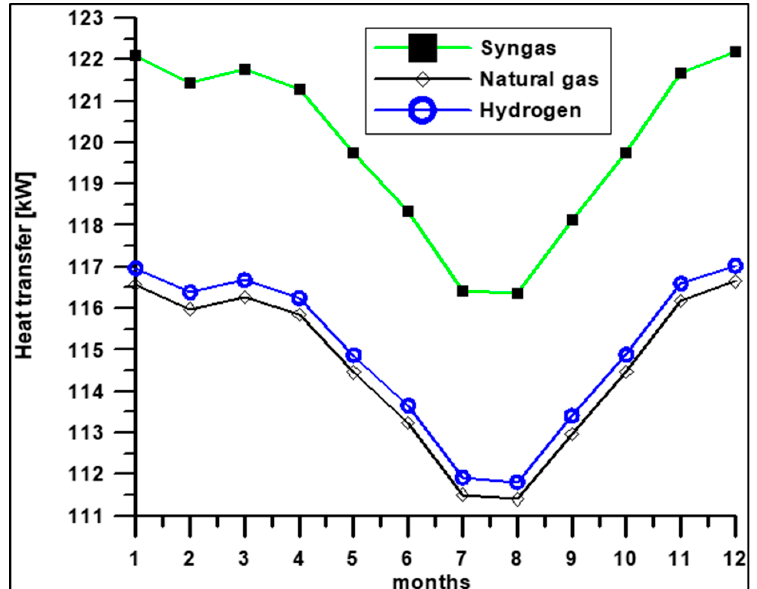
Figure 14. Heat transfer in cogeneration unit during year.